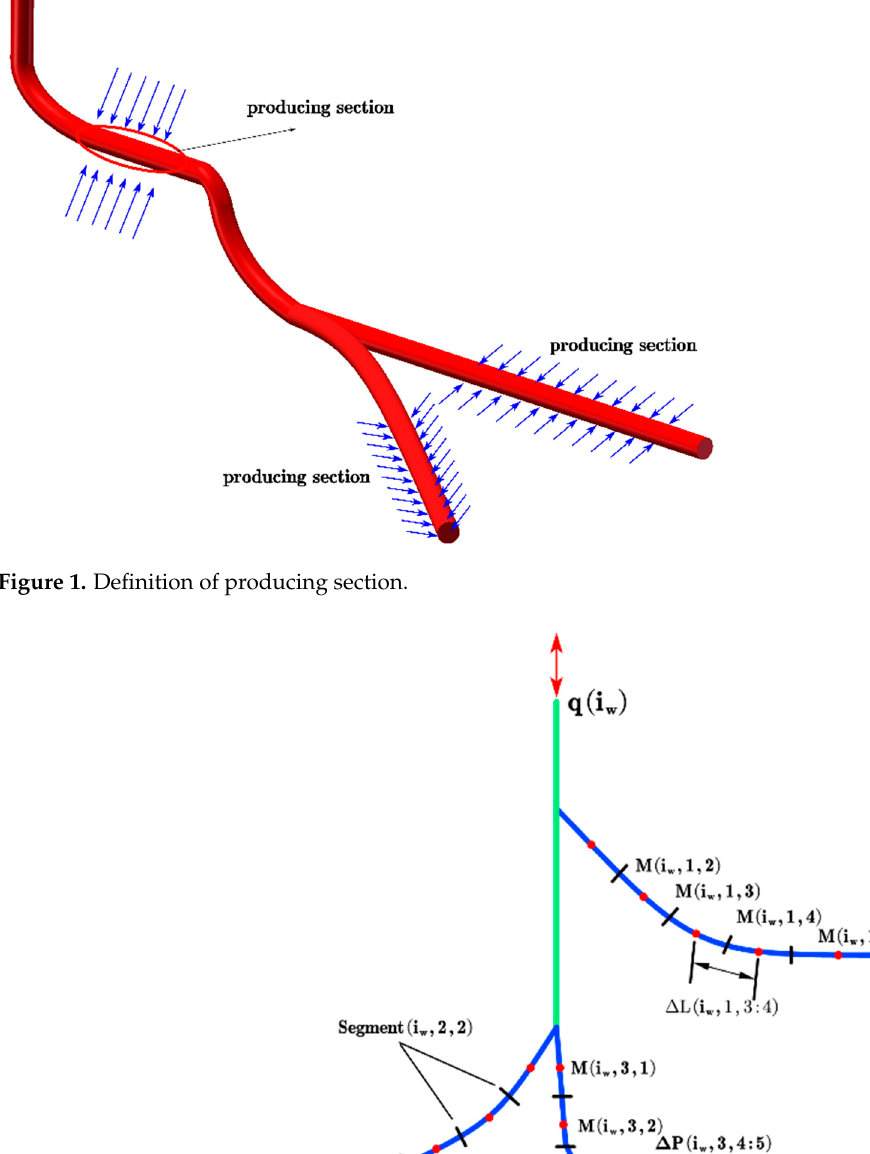
Figure 1. De fi nition of producing section.